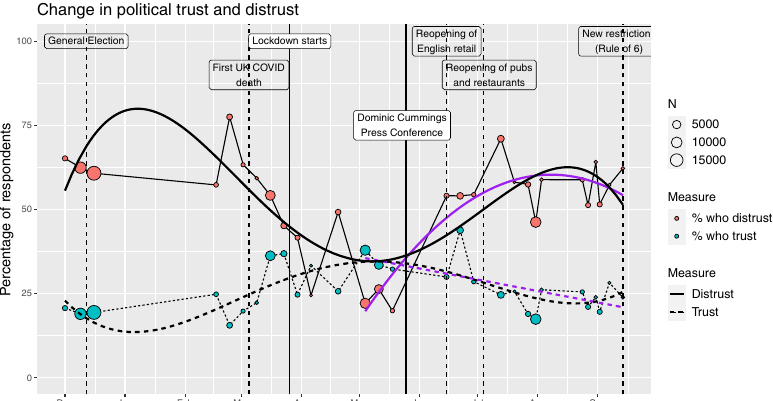
Fig. 1 Change in political trust and distrust from December 2019 to October 2020. Notes. Trend lines for the full-time period are displayed in black and trend lines for the post-Cummings period of May 2020 onwards are displayed in purple. The key events for the fi rst UK lockdown and the Dominic Cummings scandal are displayed. Other labelled events are to provide additional contextual information but are not necessarily related to changes